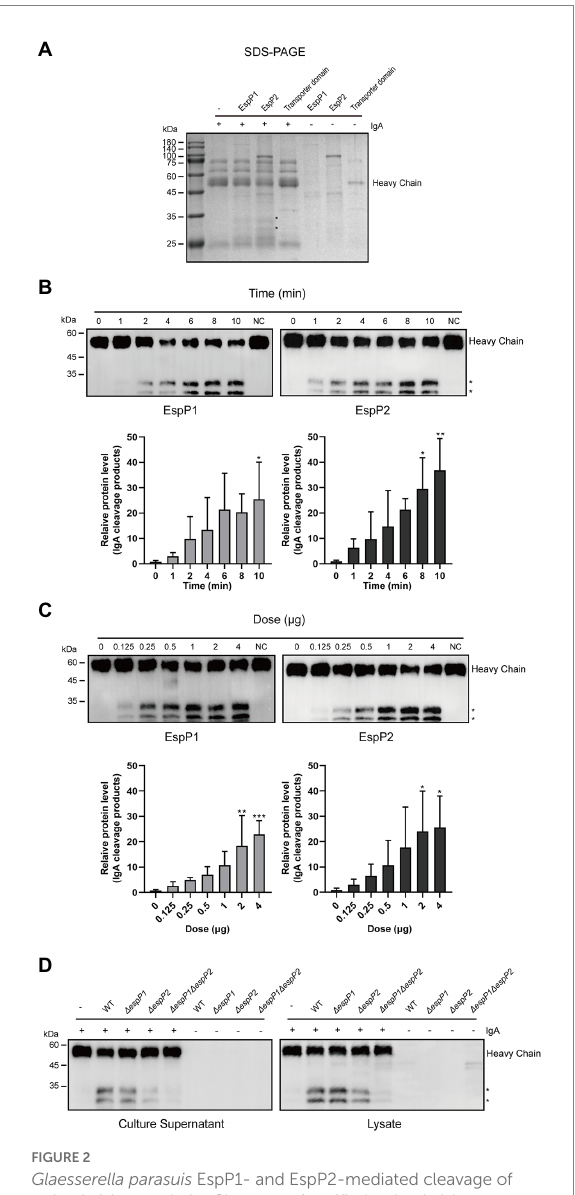
FIGURE 2 Glaesserella parasuis EspP1- and EspP2-mediated cleavage of swine IgA heavy chain. Cleavage of purified swine IgA by recombinant EspP1 and EspP2 was detected by SDS-PAGE (A) and Western blot (B,C) . The cleavage products are indicated with asterisk (*). And the IgA was cleaved in a time- (B) and dose- (C) dependent manner. (D) Lysates and culture supernatants of CF 7066 wild type (WT) and EspP1 and EspP2 defivient strain (AespP1, AespP2, and AespP1AespP2) were incubated with purified swine IgA, and the degradation of IgA was detected